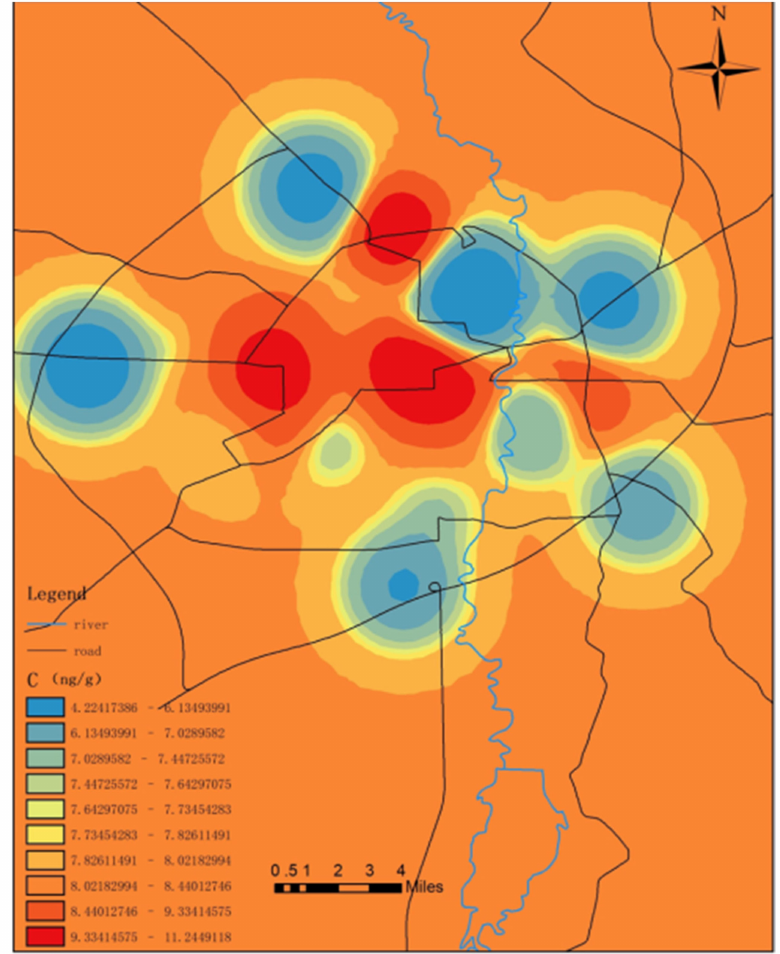
Figure 6. Distribution of mercury content in the attachments of the refuse collection points. As detailed in Figure 7, the surface mercury content near the north of the central area (within the first ring road) of the study area was obviously high and the mercury content along the west ring road was also relatively high. In the central area, we observed a relatively large flow of people and vehicles. The output of garbage was high and the total amount of mercury-containing waste was also relatively high. As a result, the surface soil mercury content had the potential to also be relatively high in the central area of the city. Other relevant studies have shown that large- and medium-sized heavy industries (such as the No. 1 Thermal Power Plant), municipal smelters, and cement plants once operated in the central area. In recent years, the majority of those enterprises have moved out. However, the surface soil has accumulated large amounts of heavy metal mercury due to the previous long-term production activities